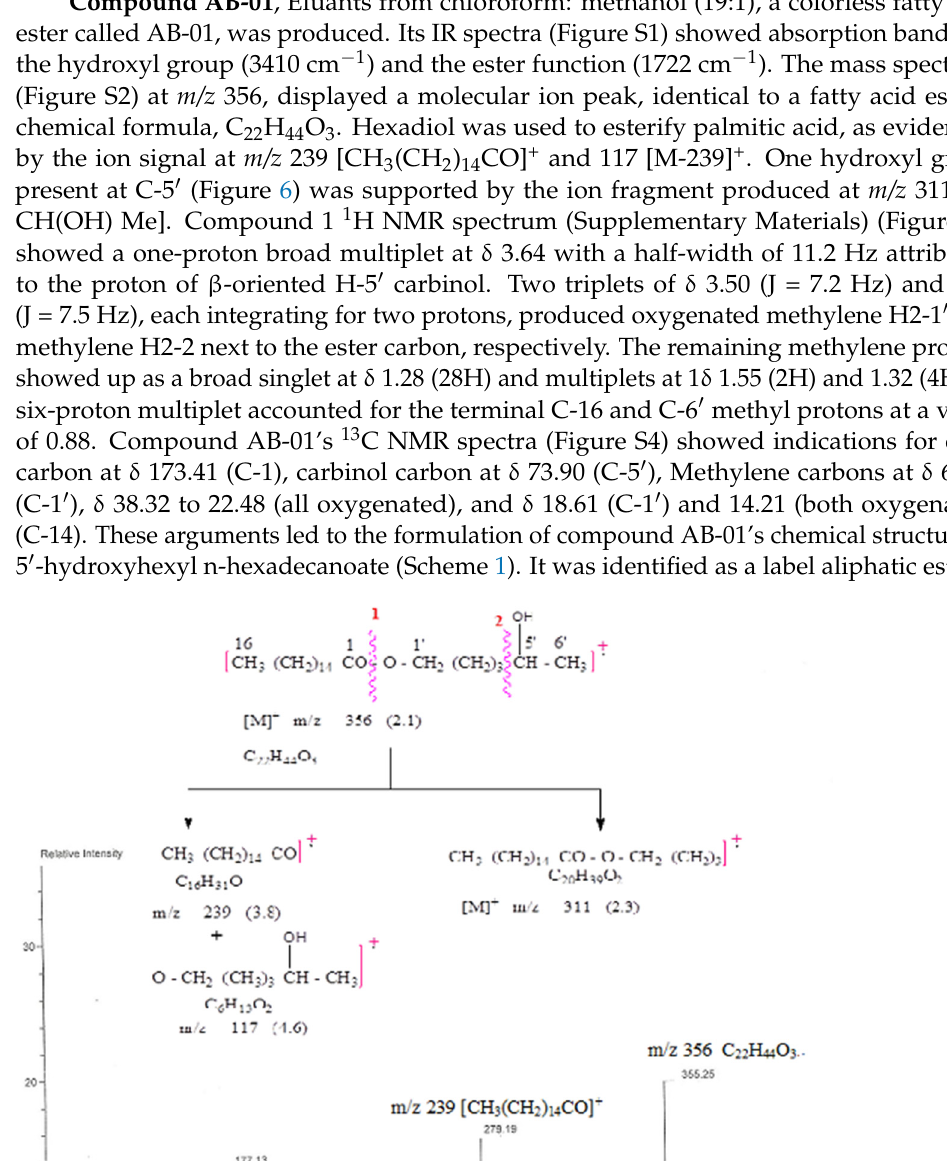
Plants 2022 , 11 , x FOR PEER REVIEW 14 of 24